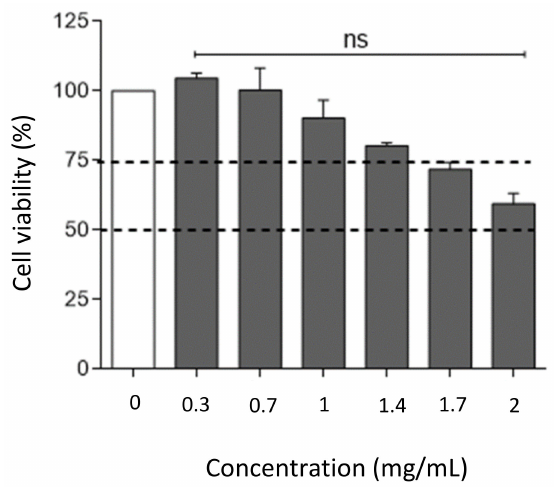
Figure 7. Evaluation of hydrogel film B2 cytotoxicity and safety on HaCaT cell line by an MTT assay. Dotted lines indicate the 50% and 75% of cell viability. ns, not significant OLE-treated versus untreated group (one-way ANOVA